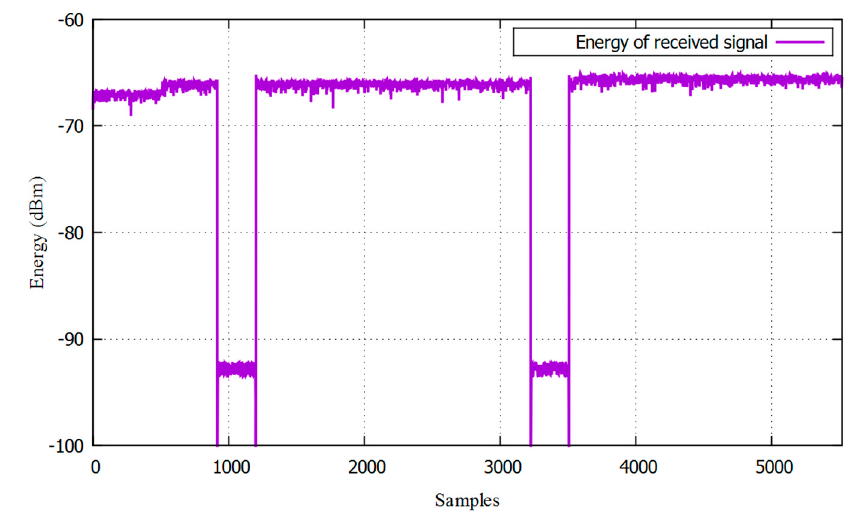
Figure 6. Average energy pattern for the Gaussian minimum shift keying (GMSK) signal.